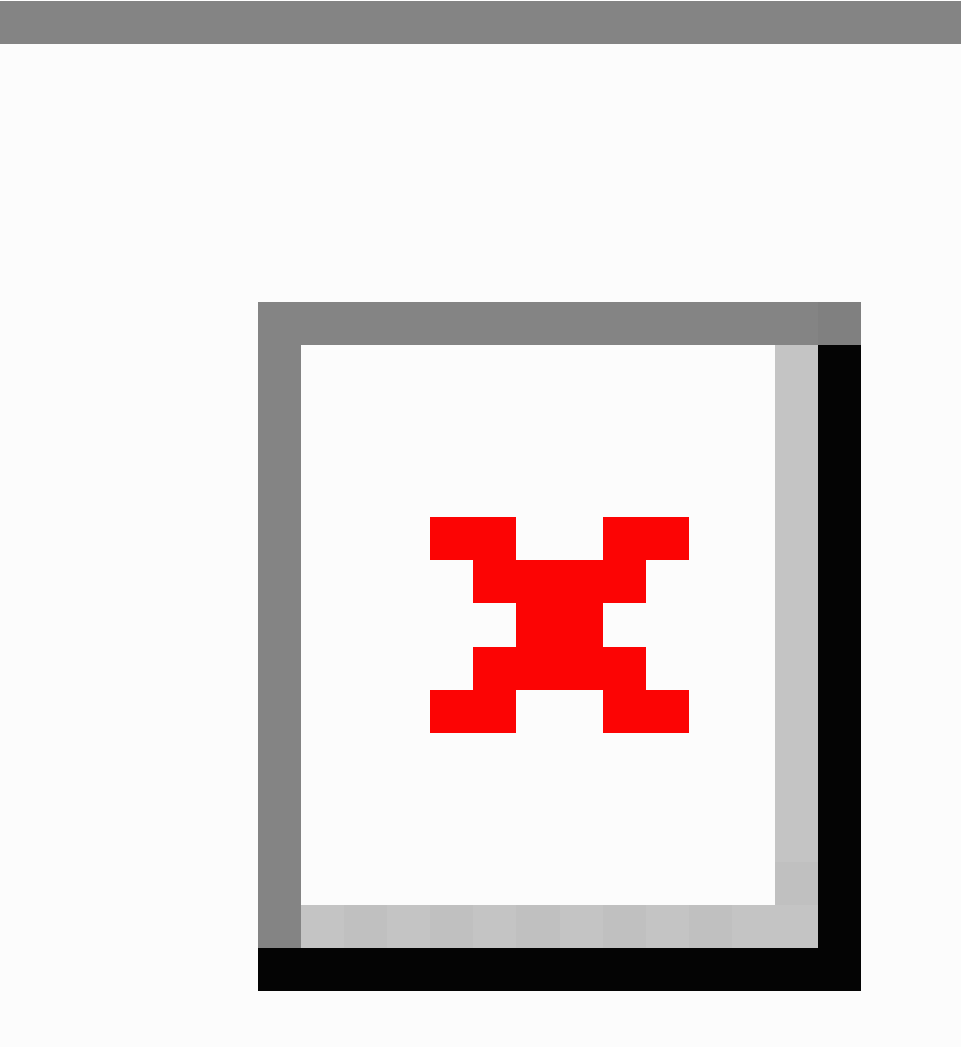
Figure 2. Screenshot and English translation of personal advice regarding prenatal alcohol